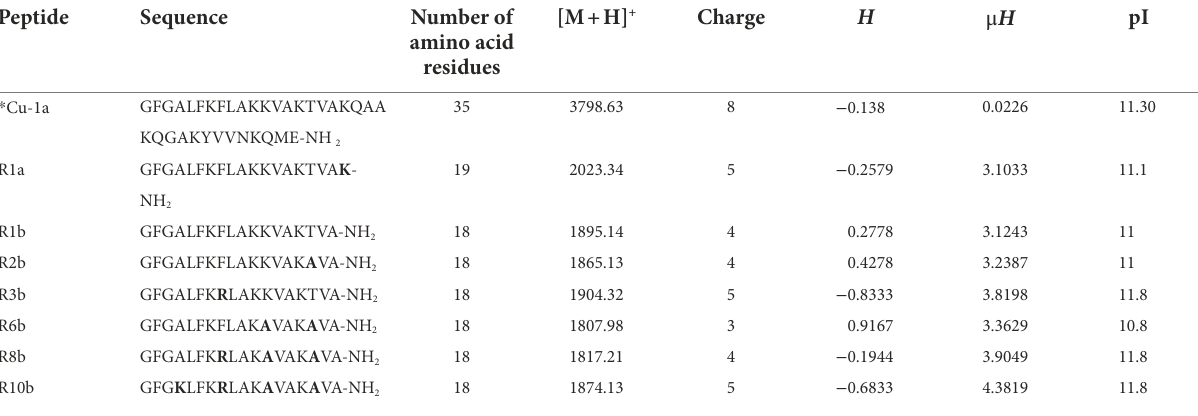
TABLE 2 Sequence, number of amino acid residues, monoisotopic molecular weight [M + H+], charge, hydrophobicity ( H ), hydrophobic moment ( μ H ), and isoelectric point (pI) of the seven analog